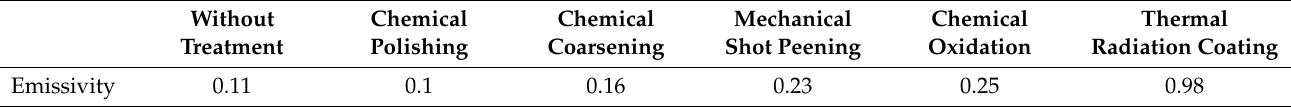
Table 2. Thermal emissivity of heat sinks with different surface treatments at 40 ◦ C.